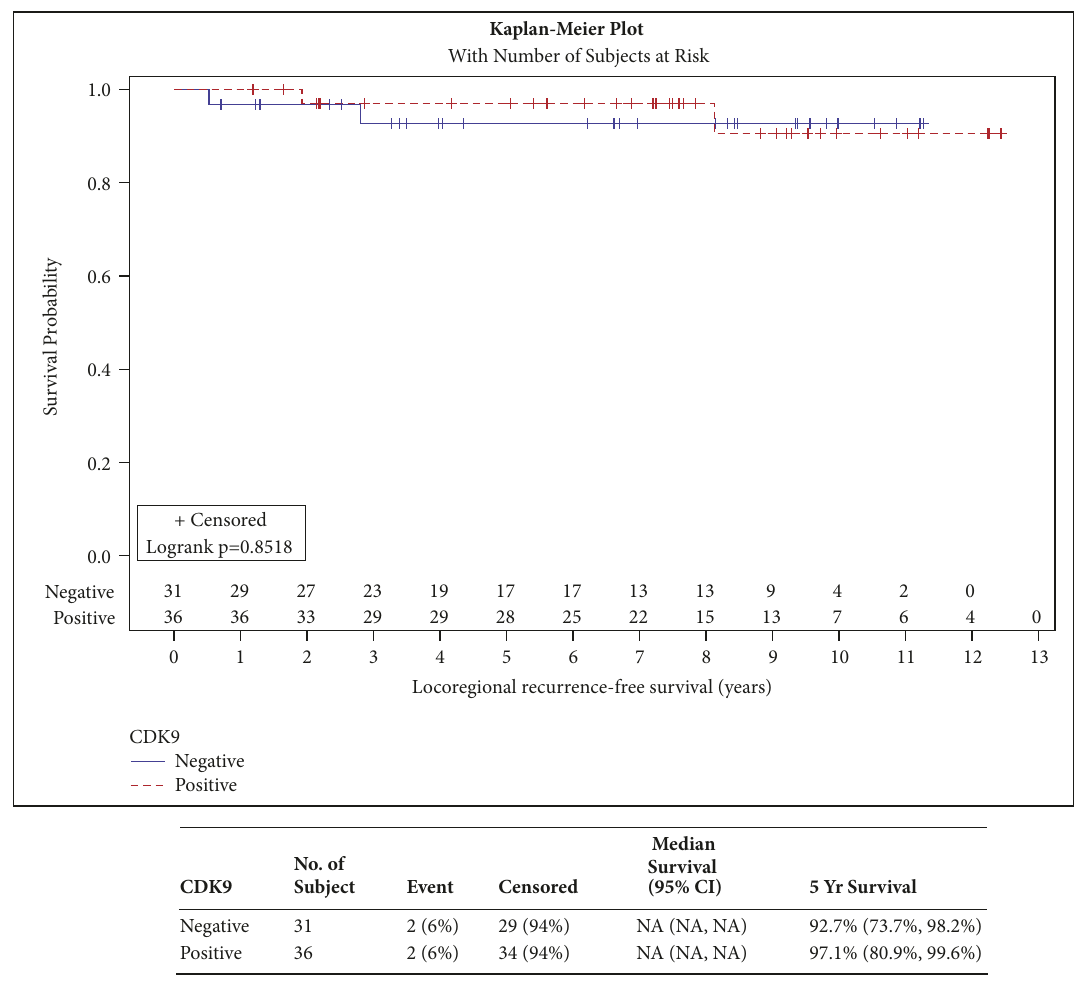
Figure 3: L ocore g ional recurrence-free survival . Figure 3 illustrates locoregional recurrence-free survival curves for patients with CDK9 positive versus CDK9 negative tumors. There is no statistically significant or observable difference in the two survival